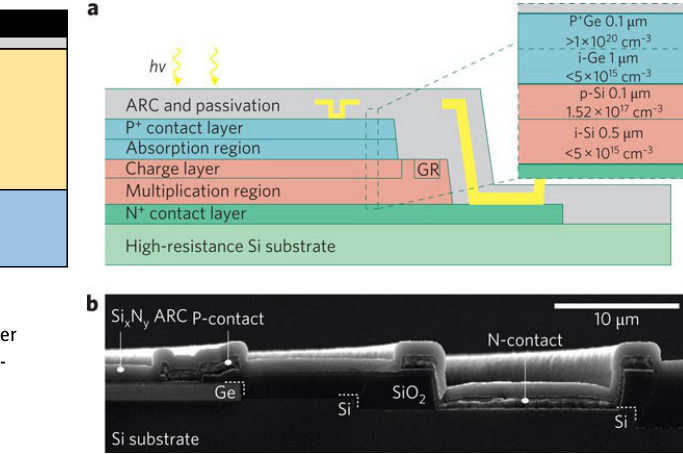
Figure 9: Separate absorption and multiplication germanium photo- diode with a heavily doped charge layer to prevent carrier multipli- cation in the germanium layer